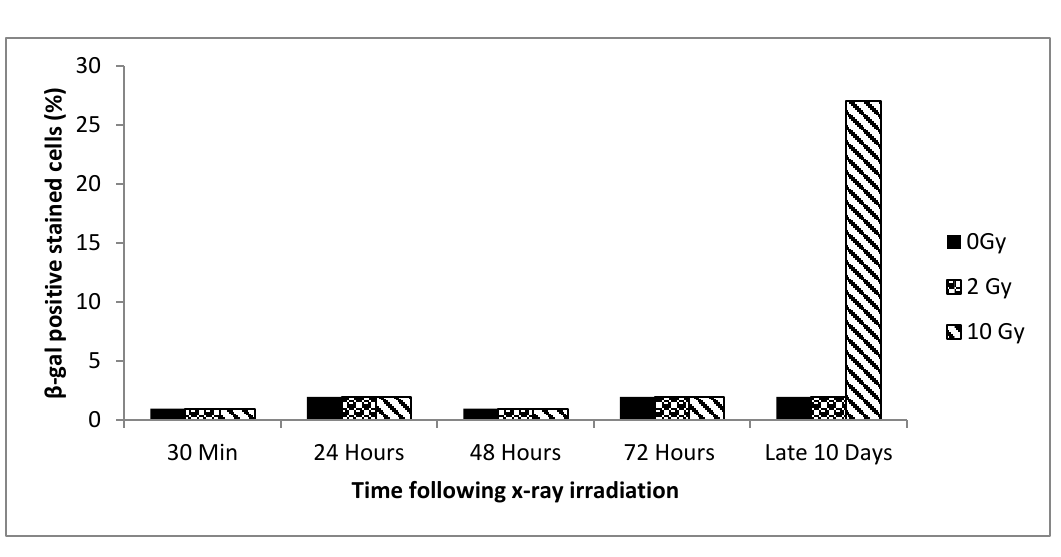
Figure 2. Results for younger cells. The percentage senescence at different time points (30 min, 24 h, 48 h, 72 h, and 10 days) after X-ray irradiation with 2 Gy or 10 Gy is shown. There is a significant difference in senescence in the 10 Gy samples between the 30 min sample and the 10 day sample (P value < 0.0001).